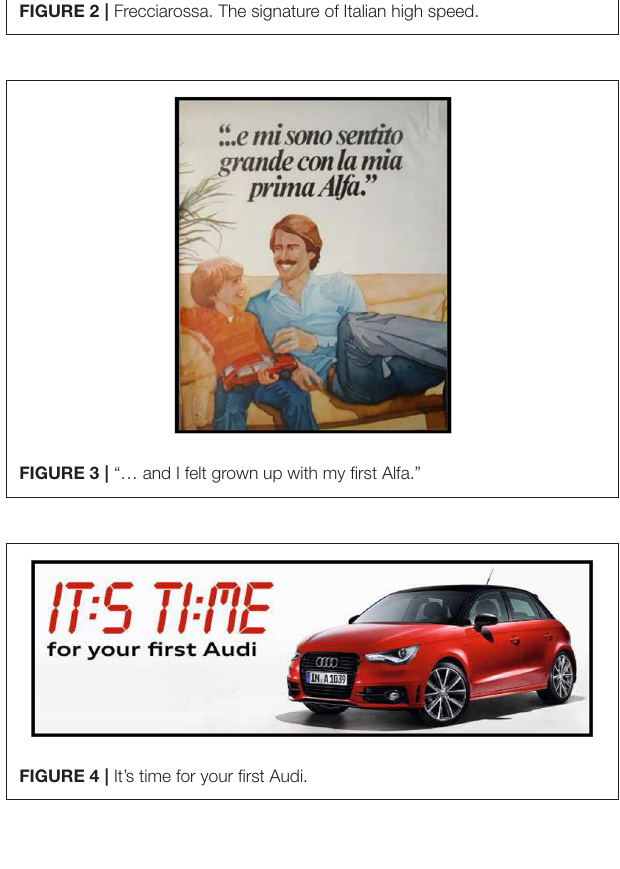
FIGURE 2 | Frecciarossa. The signature of Italian high speed.